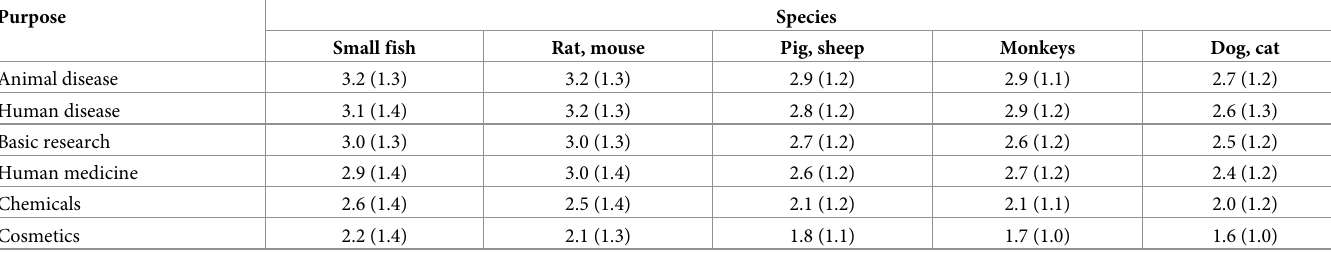
Table 3. Student ARAS-PD scores as a function of research purpose and species (1–5 scale) 1 . Purpose